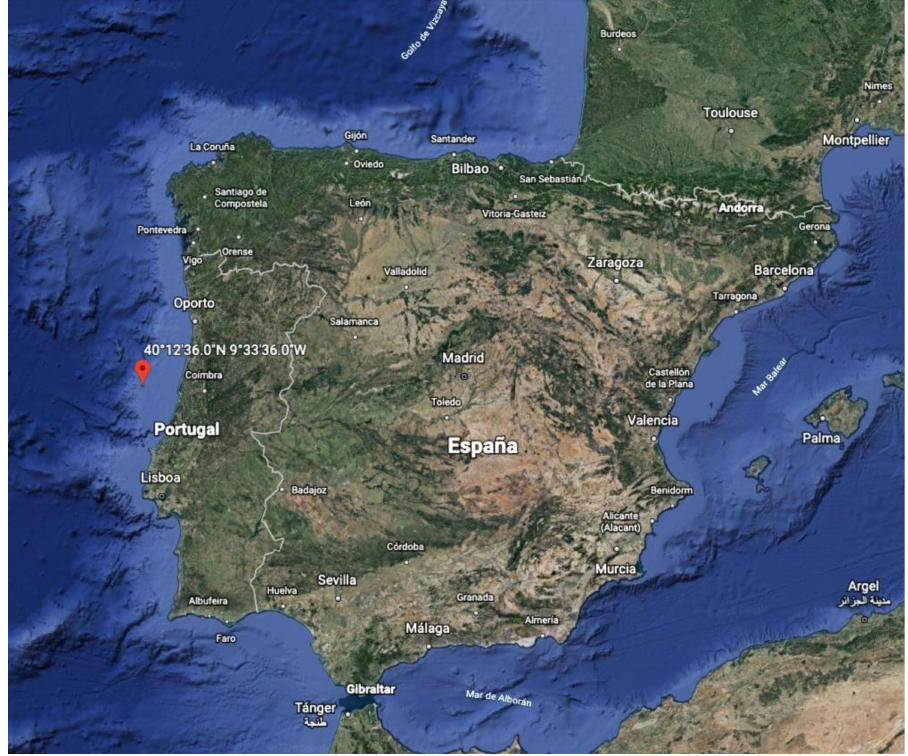
Figure 5. Case study Figueira da Foz (west coast of Portugal, Iberian Peninsula)